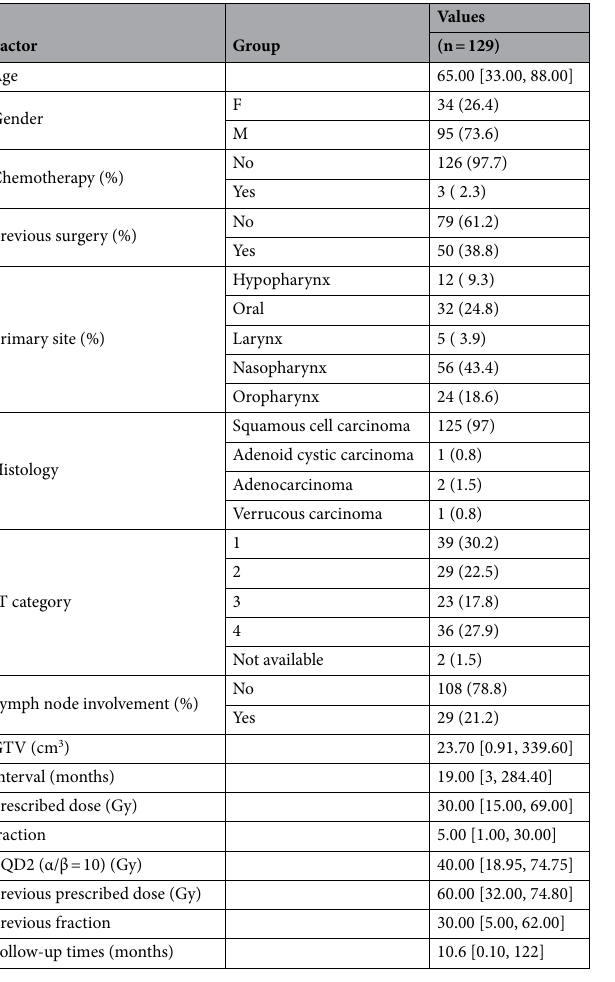
Table 1. Patient and treatment characteristics. GTV gross tumor